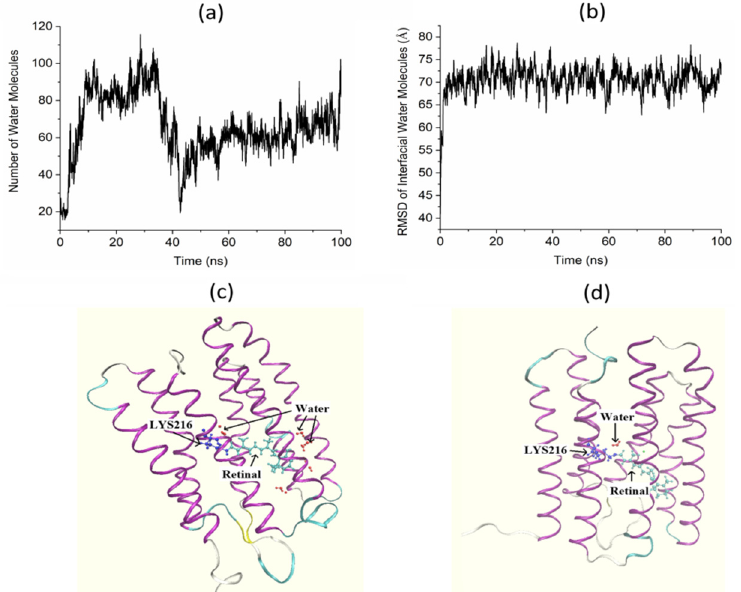
Figure 6. Role of water molecules at the interface of bR and graphene: ( a ) Number of interfacial water molecules between bR and graphene (within 5Å) during the 100 ns simulation; ( b ) Root Mean Square Deviation (RMSD) of interfacial water molecules between bR and graphene; ( c , d ) End of run screenshots showing the number of water molecules around the retinal in the presence and absence of